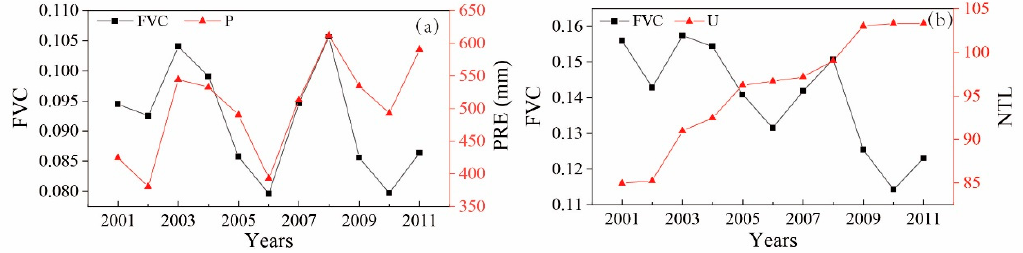
Figure 8. ( a ) Changes in FVC and precipitation in urban core areas, and ( b ) changes in FVC and urbanization in urban expanded areas. P and U indicate precipitation and urbanization, respectively.